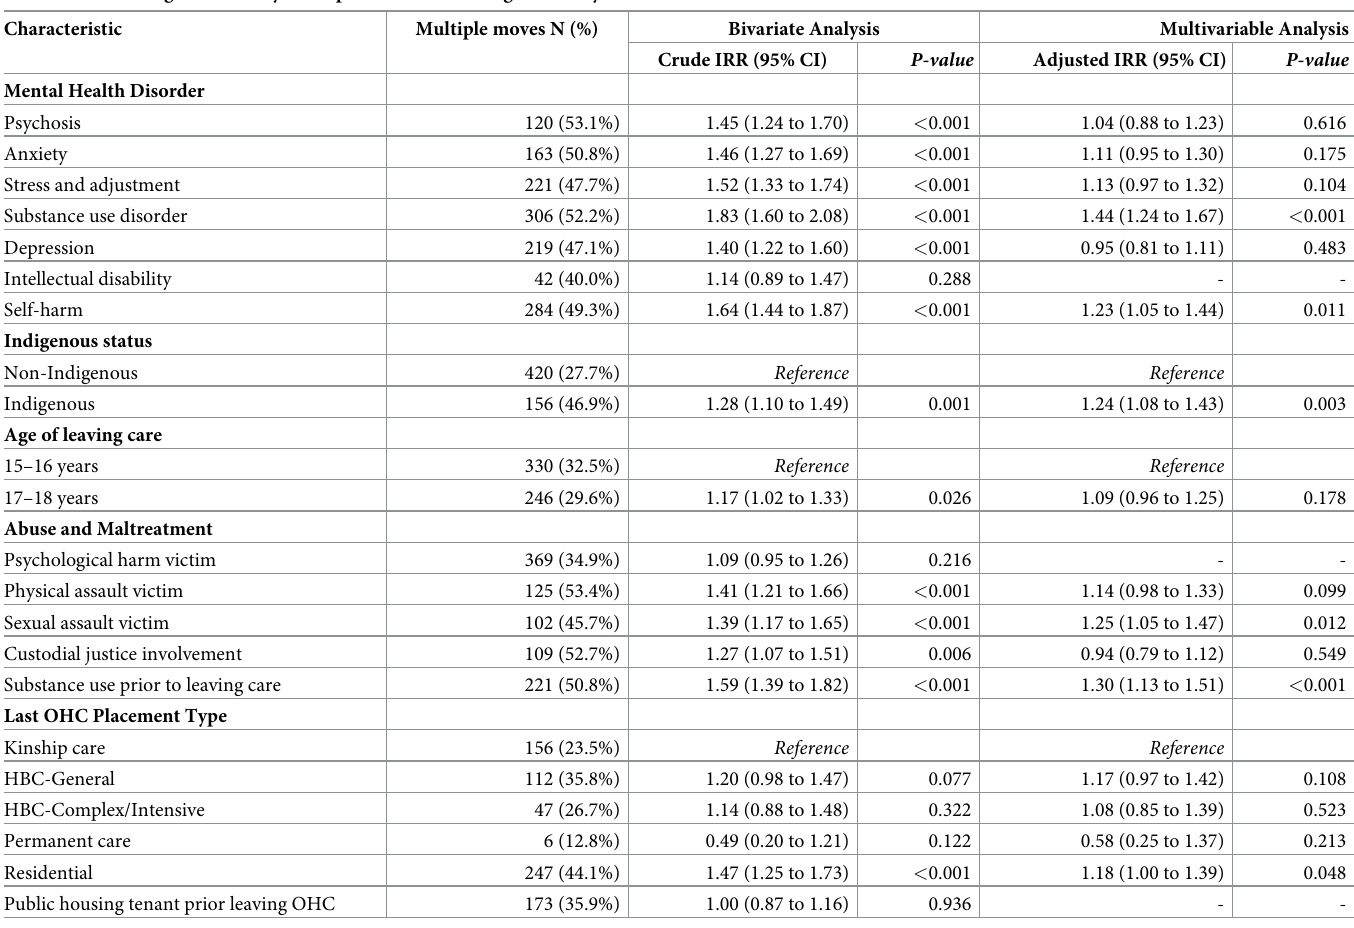
Table 6. Poisson regression analysis for predictors of housing